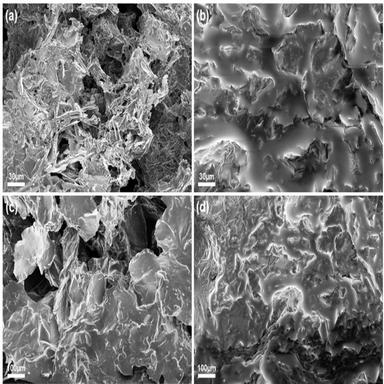
Cross-sectional image of (a,c) PA-PDMS/raw EG and (b,d) PA-PDMS/EG-PDMS composites.